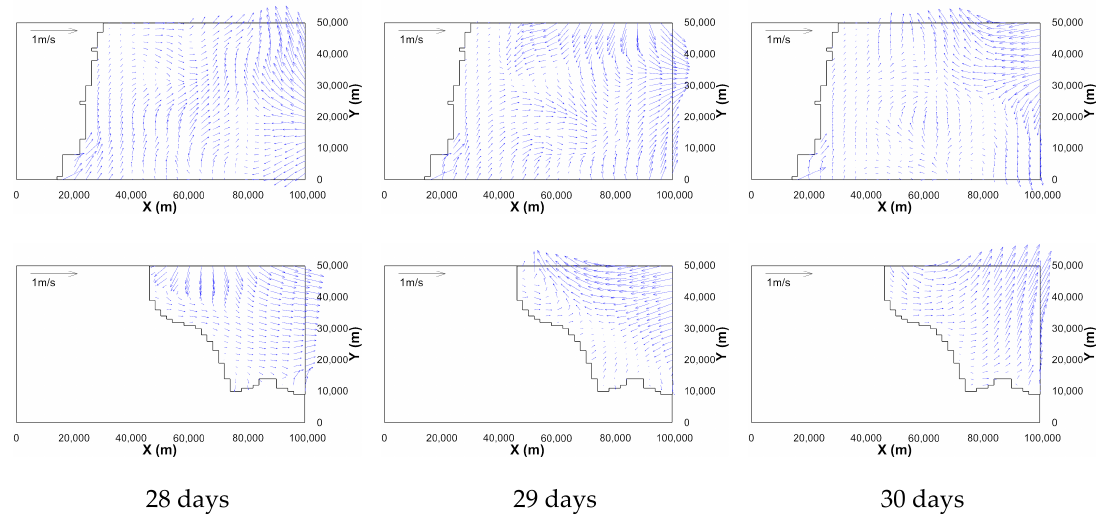
Figure 6. Velocity vector fields on the horizontal planes (upper rows: near free surface, lower rows: z = –187 m) at 28, 29, and 30 days after the start of simulation (data are skipped by 2).